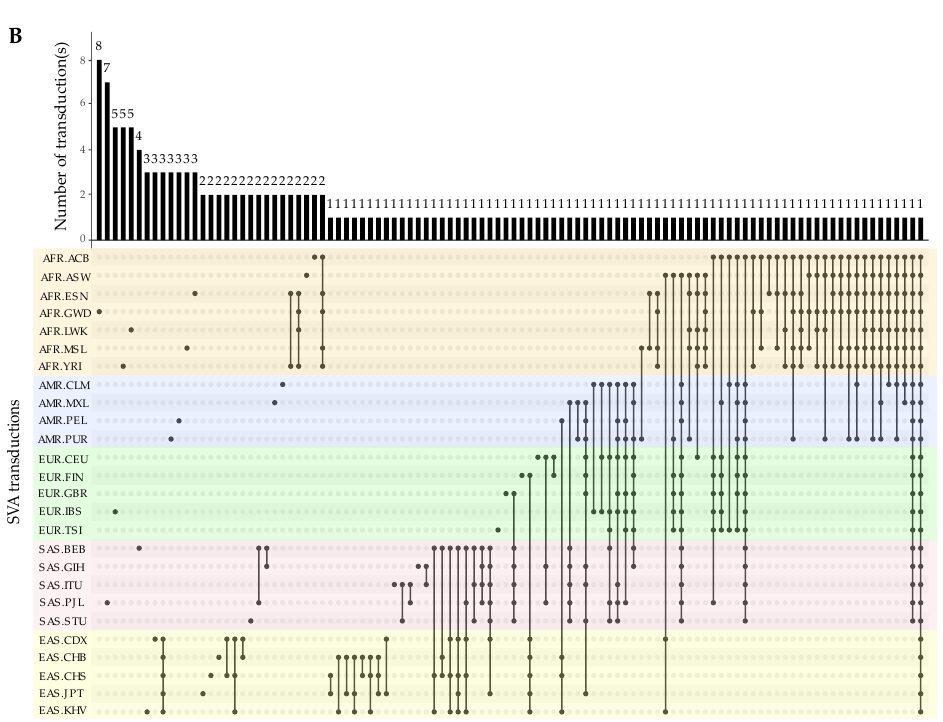
Figure 6. Distribution of unique and shared 3 (cid:48) transduction loci (high-confidence events) across 26 populations. ( A ) Transductions mediated by L1 elements. ( B ) Transductions mediated by SVA elements. Bars above the Upset plots represent the count of either population-specific or shared loci among populations. Populations are color-coded based on their super-populations (Table